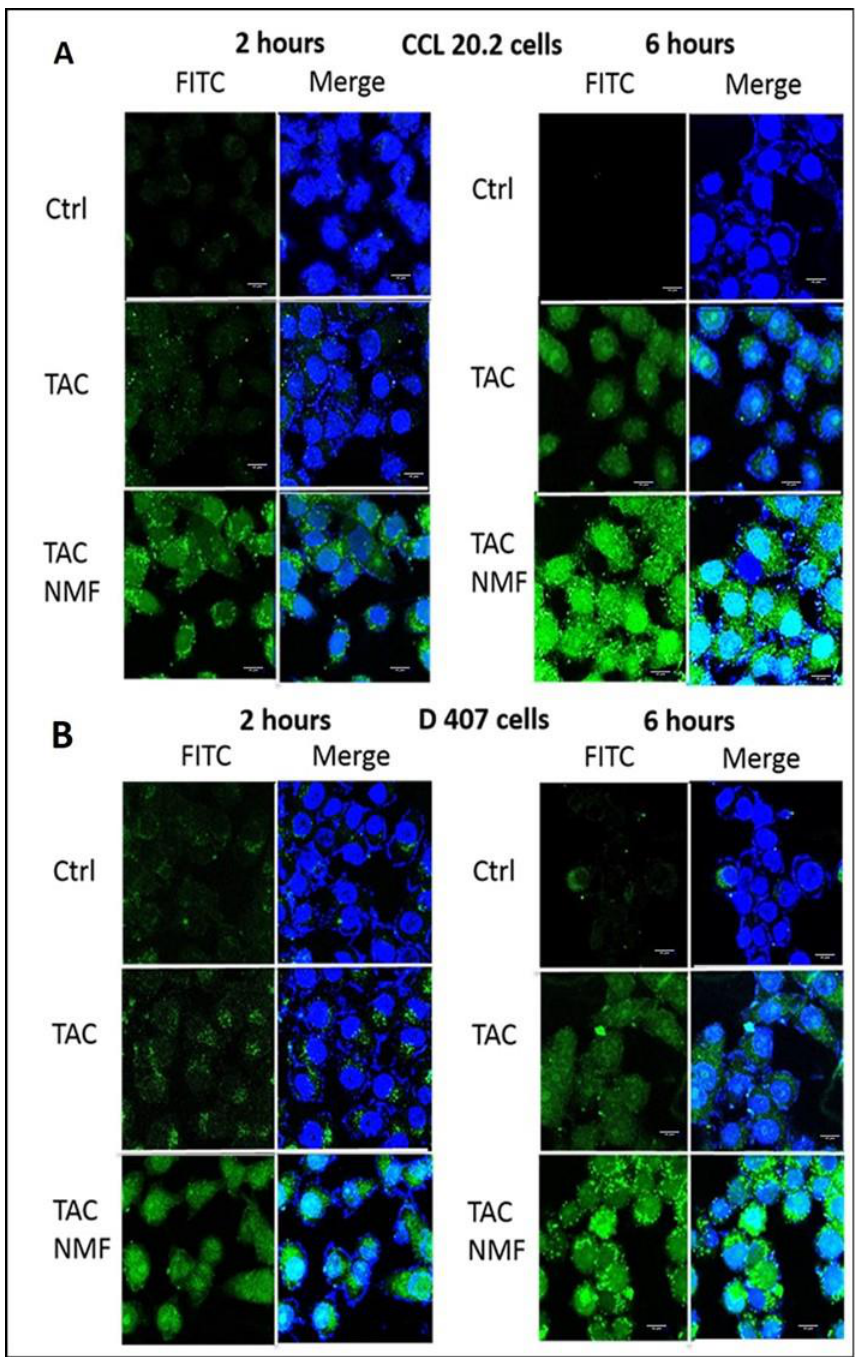
Figure 11. Time dependent uptake of FITC-labelled TAC solution and FITC-labelled TAC-NMF solution in ( A ) CCL 20.2 and ( B ) D407 cells